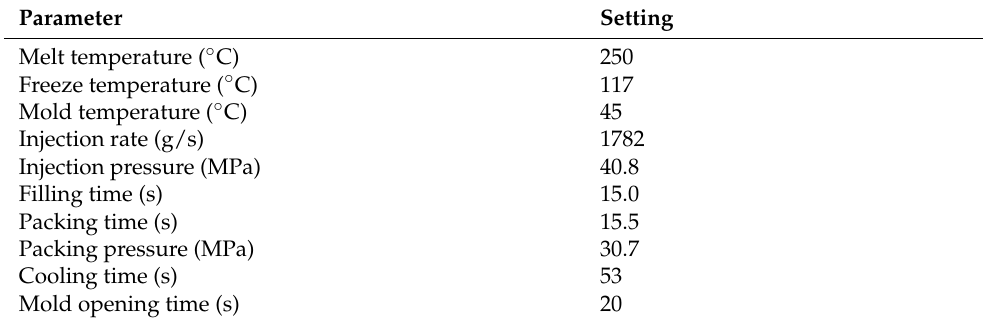
Table 1. Injection molding parameters of recycled polypropylene [14].